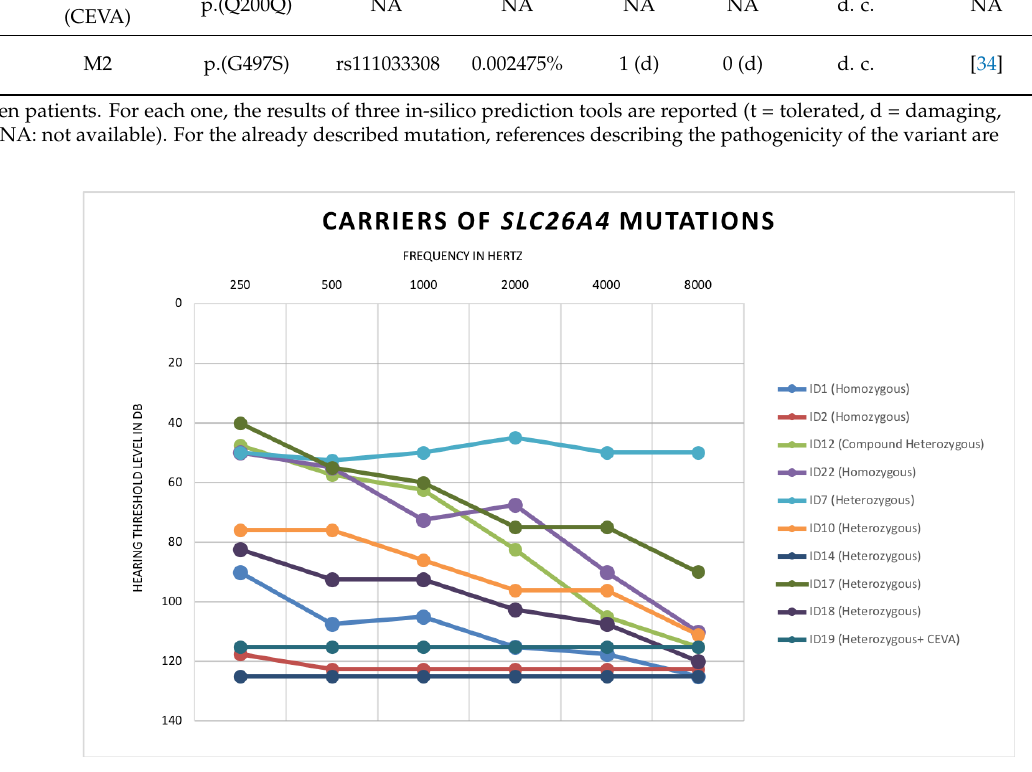
Table 2. SLC26A4 gene variants identified in the selected cohort of suspected PDS patients.